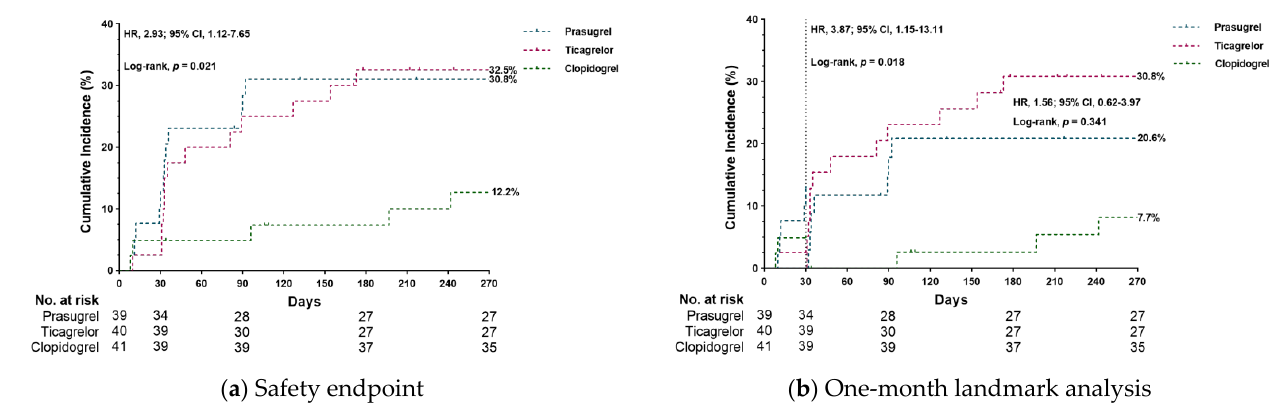
Figure 3. Cumulative incidence of safety endpoints (composite of BARC type 1 or 2 bleedings). ( a ) Kaplan – Meier estimate of safety endpoints at 9 months; ( b ) Landmark analysis at 1 month for safety endpoints.